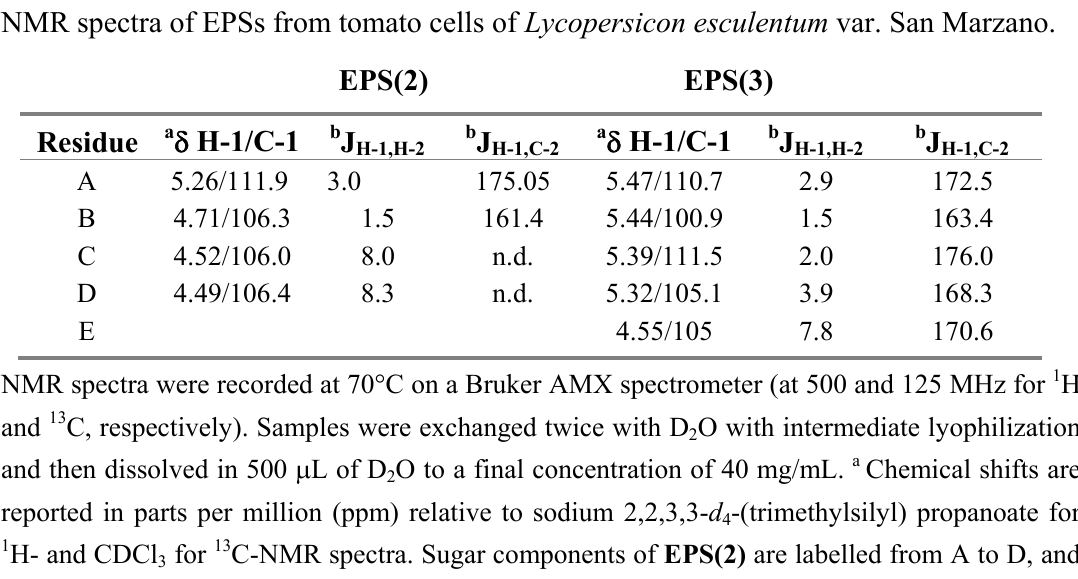
Table 2. Chemical shifts a and coupling constants b of anomeric signals in the 1 H- and 13